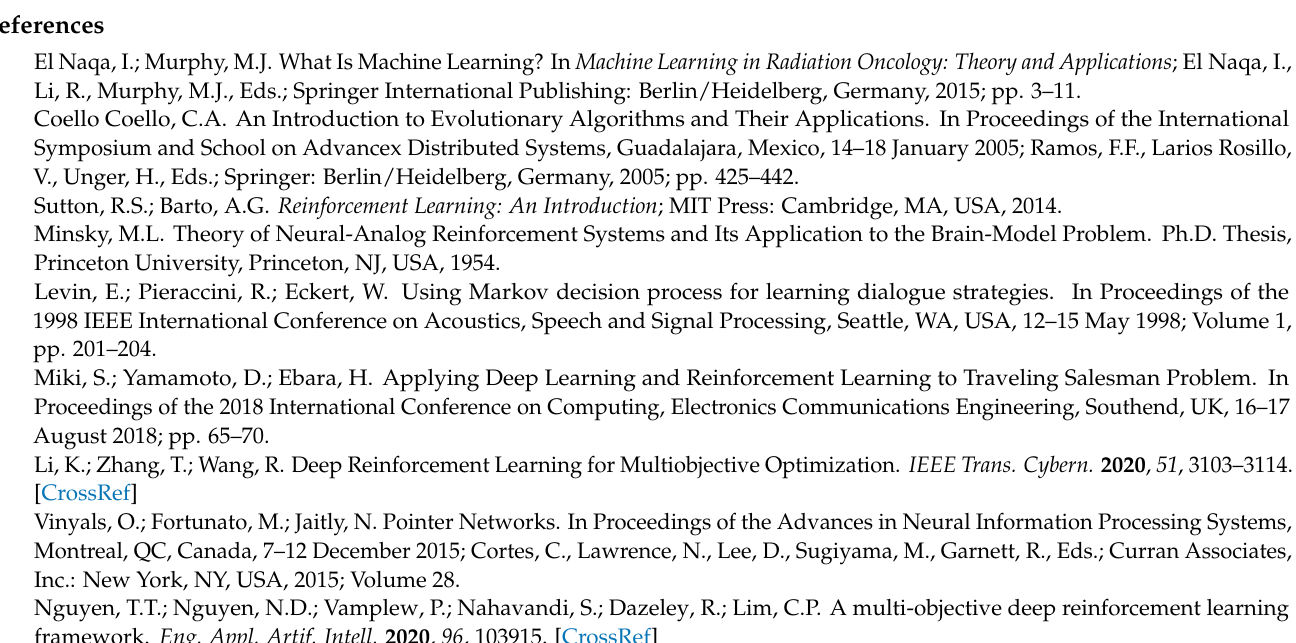
Figure A4. CPF ranking results for 150 cities ( top row) and 200 cities ( bottom